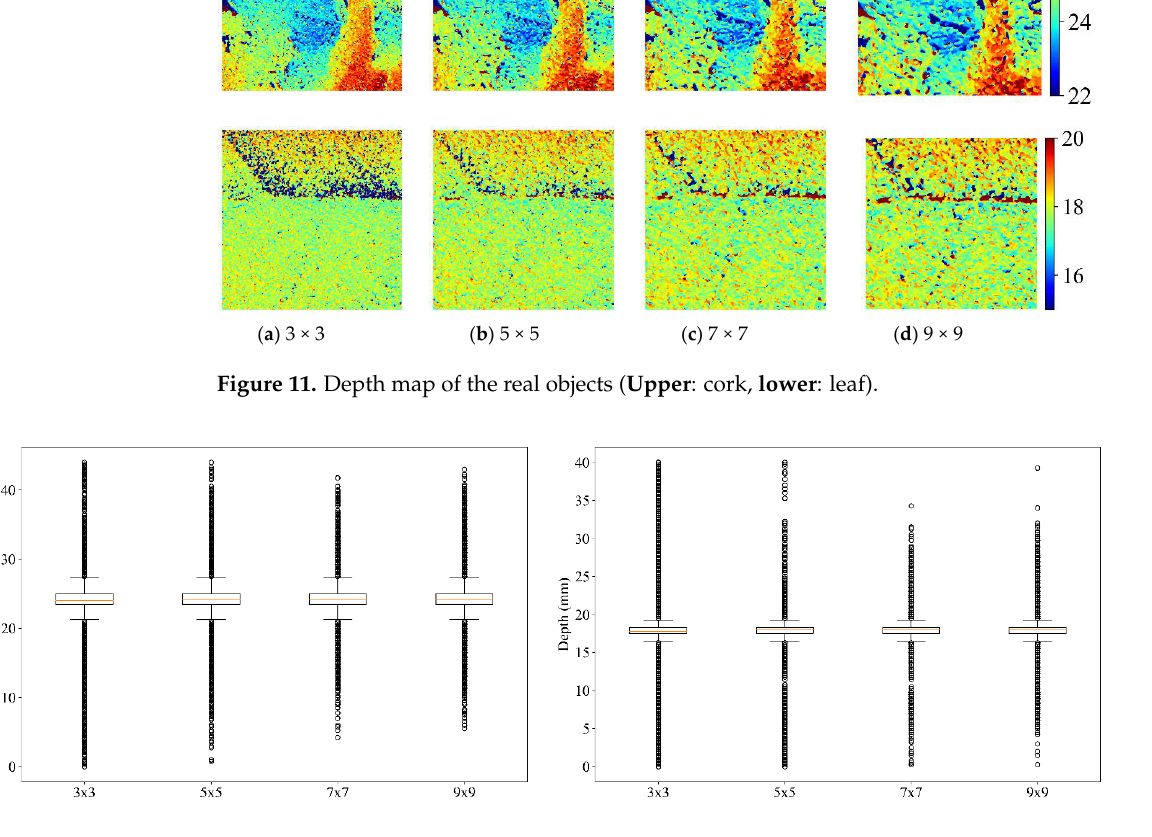
Figure 12. Depth distributions of the window sizes. In the 7 × 7 window size, the outliers were slightly reduced.